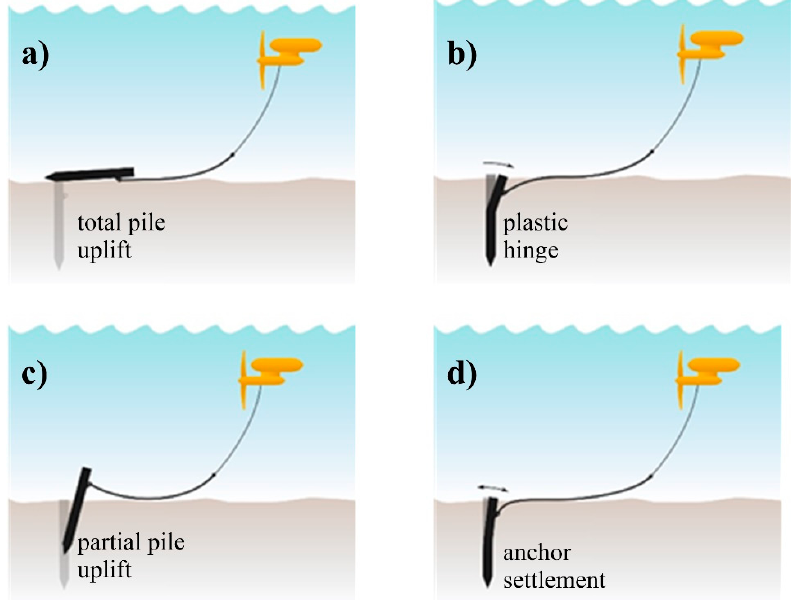
Figure 3. Examples of limit states of pile anchors for ocean current turbines, ( a ) ULS: total pile uplift; ( b ) ULS: formation of a plastic hinge in steel piles; ( c ) SLS: malfunction derived from a partial pile uplift; ( d ) SLS: security risk due to anchor settlement.